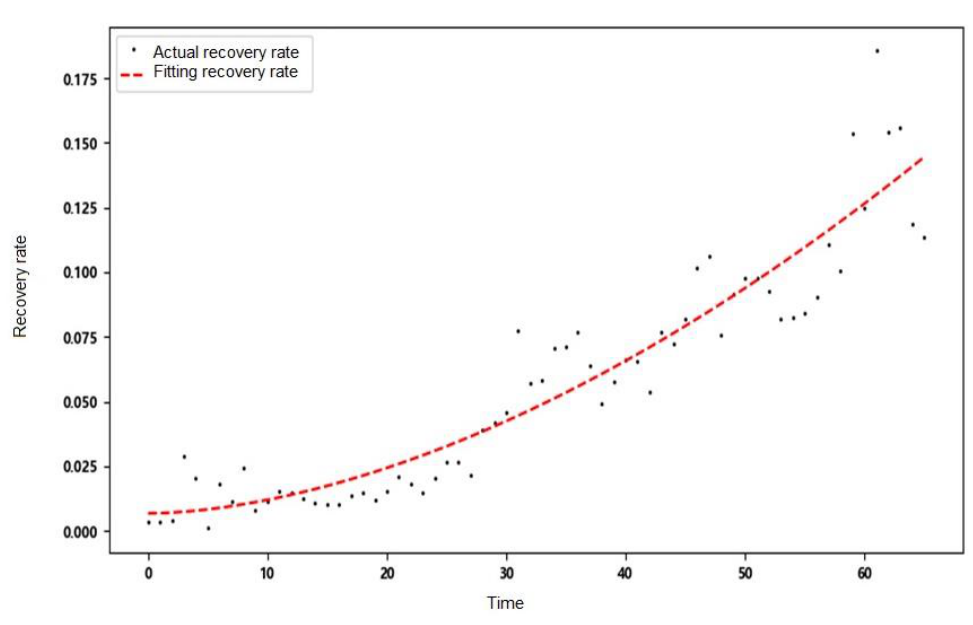
Figure 4. Fitting results of daily death rate. 3. Simulation Results and Analysis This paper verifies the accuracy of the SEAIHR model by comparing the simulation results with the real epidemic data. The experiment used the root-mean-square error (RMSE) and the average relative error (MAPE) of the fitting data and the number of con- firmed cases as the model accuracy indicators, which are defined as follows: RMSE = √ 1 𝑡 ∑